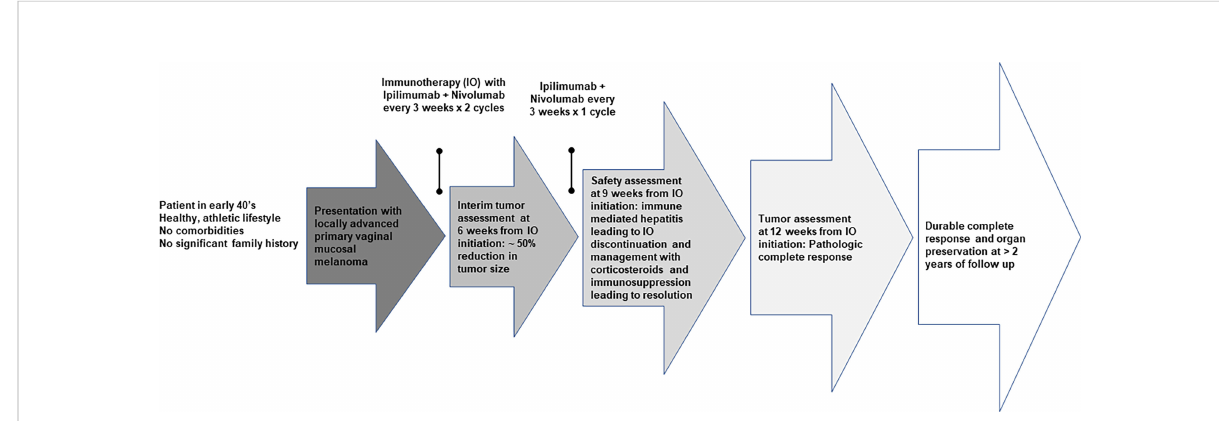
FIGURE 4 Timeline with relevant data from the